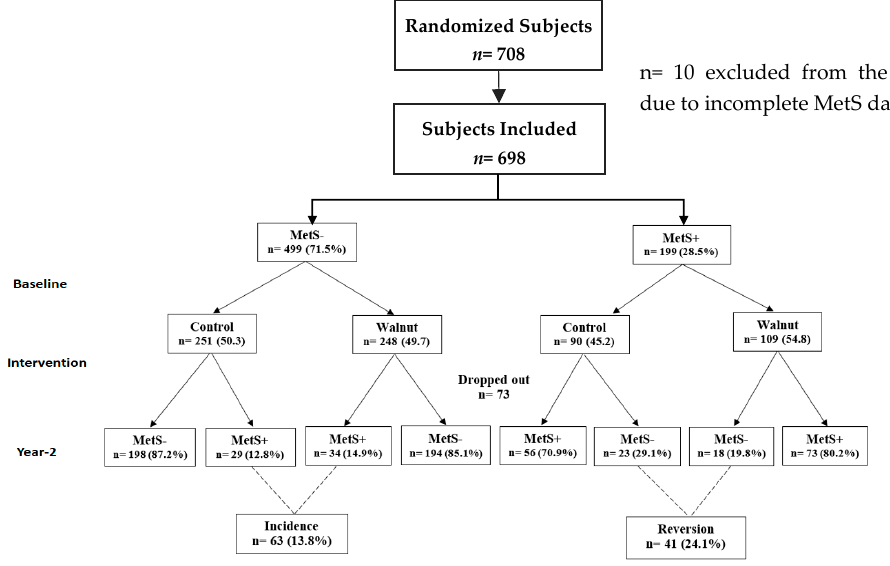
Figure 1. Classification of the development and regression rates of Metabolic Syndrome.